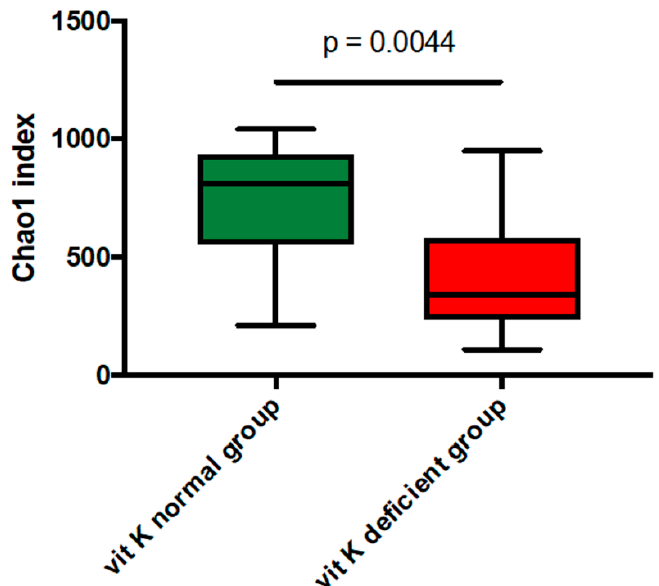
Figure 1. The mean Chao1 index between vitamin K-deficient group and vitamin K-normal group. The mean Chao1 index was significantly lower in vitamin K-deficient group than in vitamin K-normal group ( p = 0.0044). vit K, vitamin K.